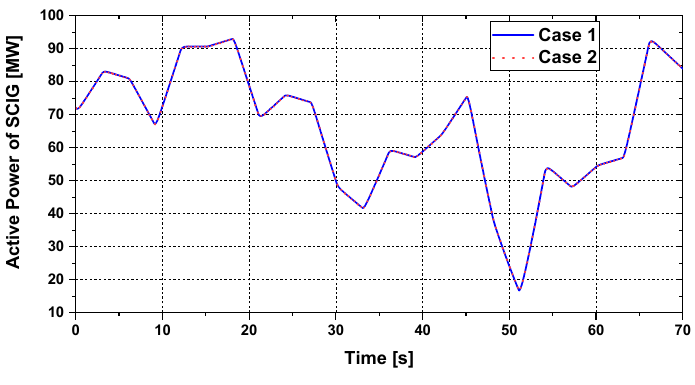
Figure 17. Wind speed applied to FSWT-SCIG.